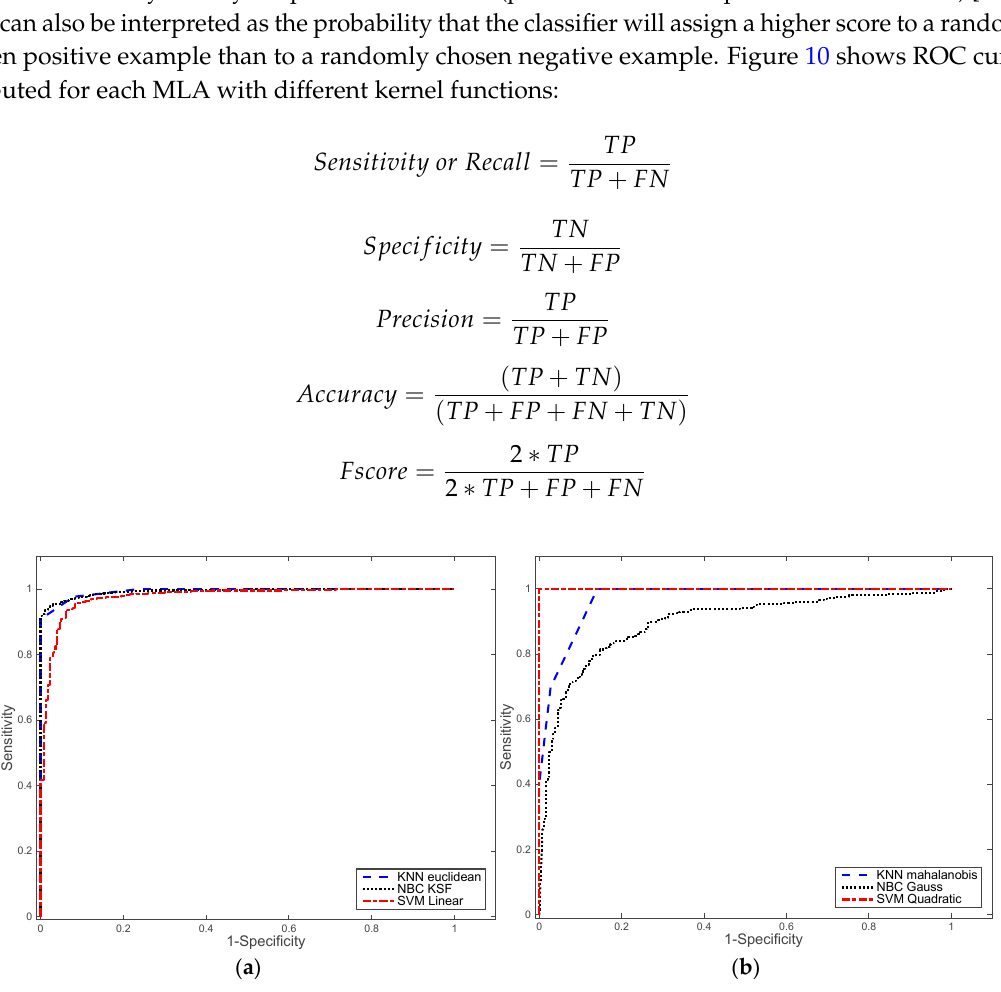
Figure 10. ROC results: ( a ) kNN classifier with Euclidean distance, NBC with KSF, and SVM classifier with linear functions; ( b ) kNN classifier with Mahalanobis distance, NBC with Gauss kernel, and SVM classifier with quadratic polynomial function.